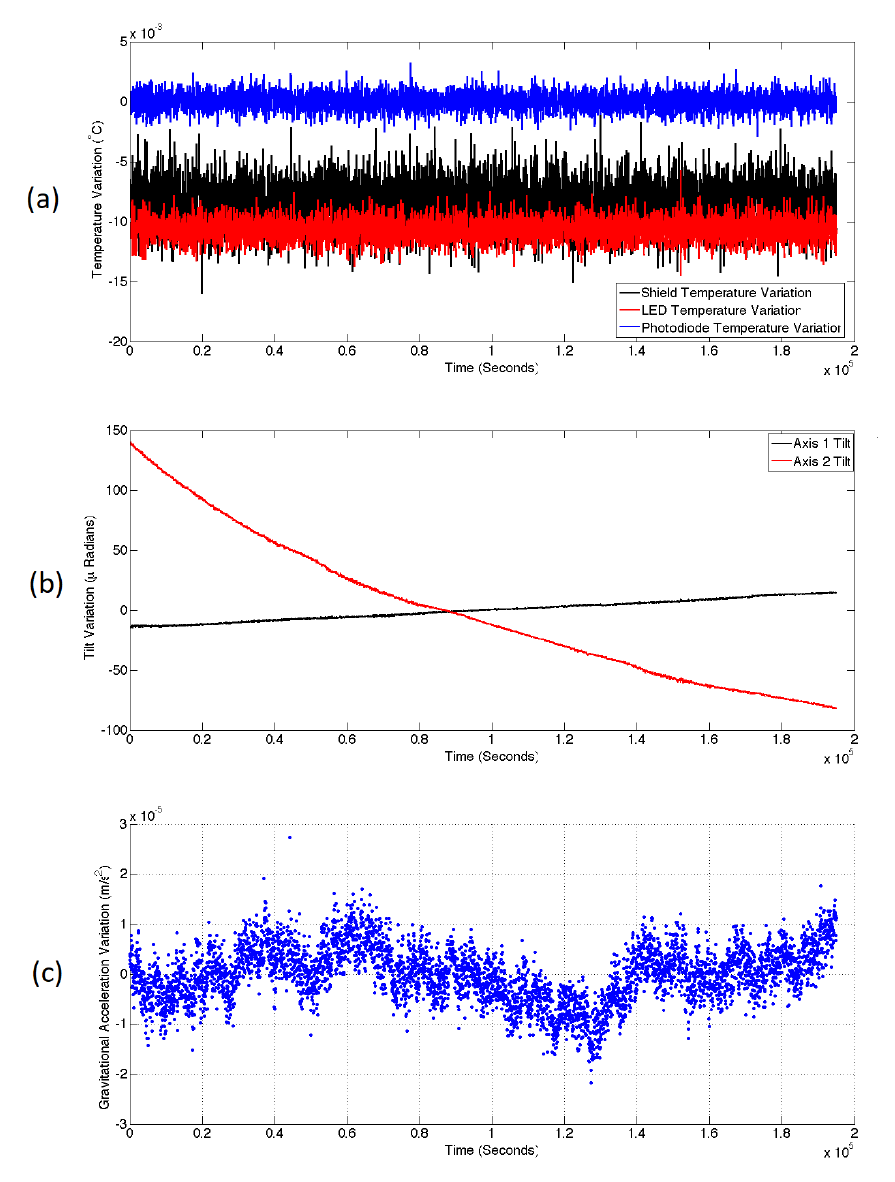
Figure 4. The noise performance of the MEMS gravimeter over a period of 54 h. ( a ) Shows the normalised temperature variation of the shield, LED and Photodiode over this period. These temperatures were stabilised using a proportional integral derivative (PID) control mechanism. ( b ) Shows the tilt of two orthogonal axes of the device. The large variation of axis 2 was caused by the sinking of the device into the linoleum of the laboratory floor. ( c ) Shows the acceleration output of the device over this period. A multiple linear regression has been performed on this data to remove the effect of the tilt and a residual linear drift. It is not expected that the Earth tides could be observed with this noise level, but if a lower frequency device were inserted into the sensor then such an observation could be